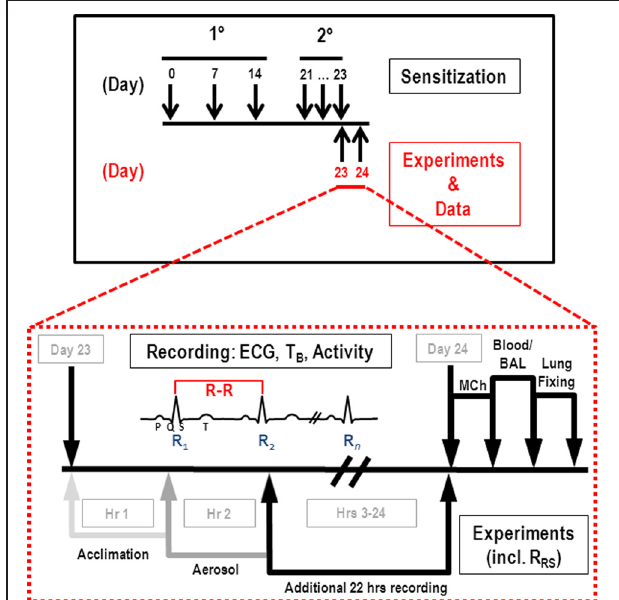
FIGURE 1 | Sensitization and experimental protocols. Primary (i.p., injection) and secondary (aerosol) sensitizations occurred as indicated in the upper panel; expanded view comprises the third aerosol challenge (OVA or saline) on day 23. HR, T B , and activity data were collected on day 23 as indicated for 1h prior to aerosol (light gray arrow), 1h during aerosol (gray arrow), and 22h post-challenge (black arrow). Subsequently, MCh challenge (R RS ) was performed, and blood and BAL samples collected for analysis of inflammatory